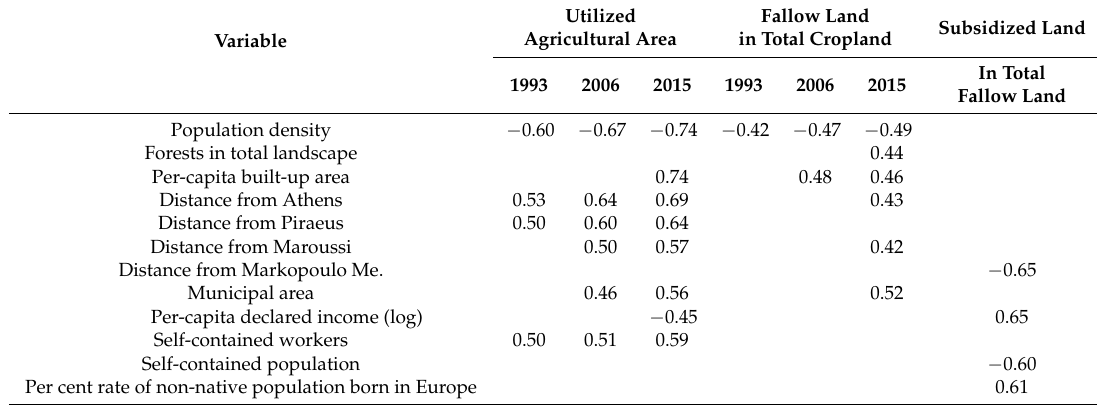
Table 2. Results of a Spearman rank correlation analysis (significant coefficients at p < 0.05 were